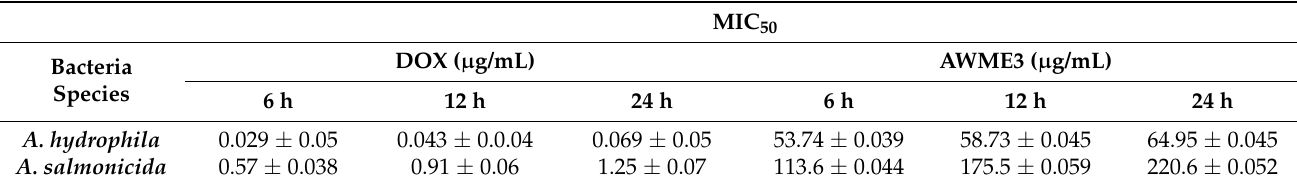
Table 3. The antimicrobial efficacy of AWME3 and doxycycline (DOX) against Aeromonas spp. at different times of